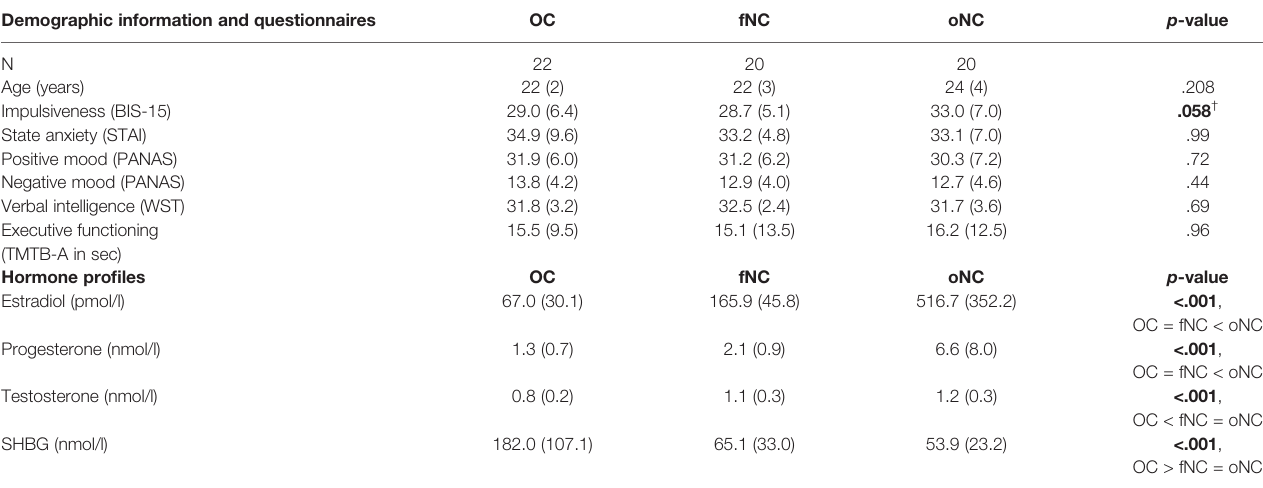
TABLE 1 | Sample description (mean and standard deviation) and hormone pro fi les per hormonal pro fi le group. Demographic information and